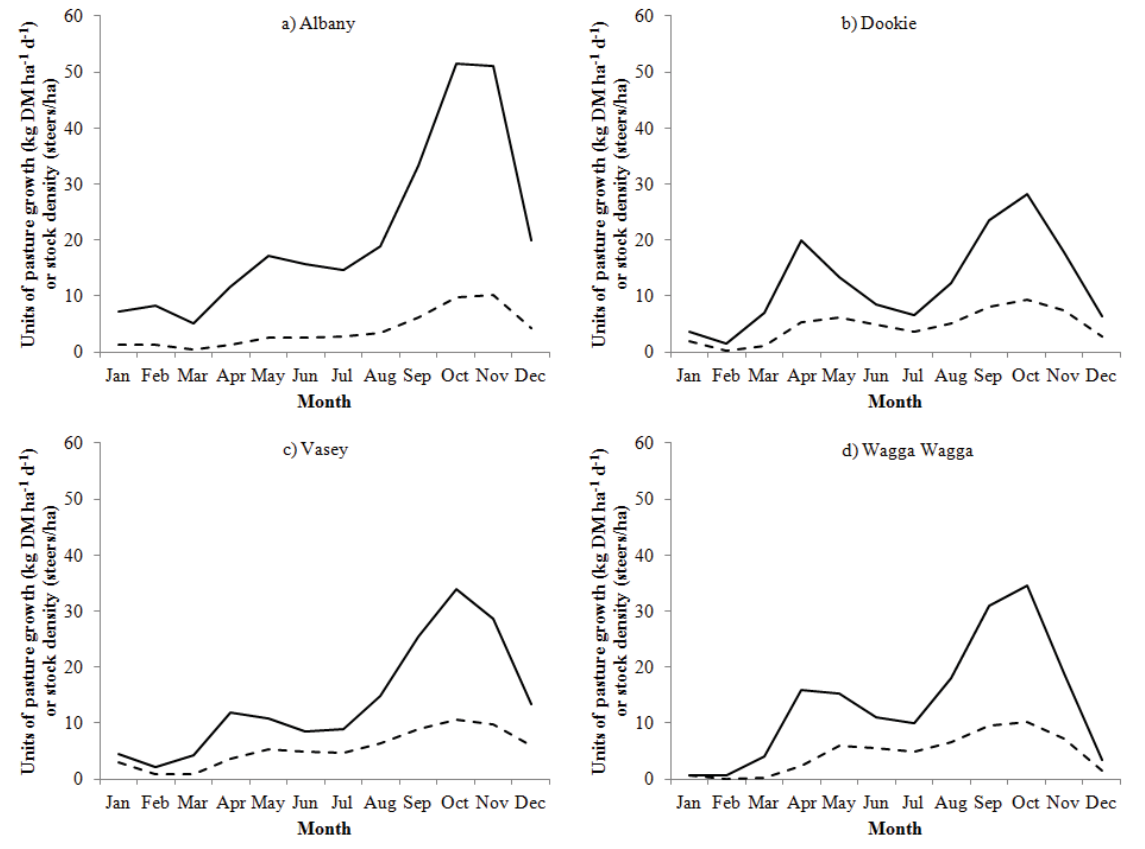
Figure 1. Predicted average daily pasture growth ((cid:3); kg DM ha (cid:2)1 d (cid:2)1 ) and stock density (- -; steers/ha) from January to December for the years of 1971 to 2000 at ( a ) Albany, ( b ) Dookie, ( c ) Vasey and ( d ) Wagga